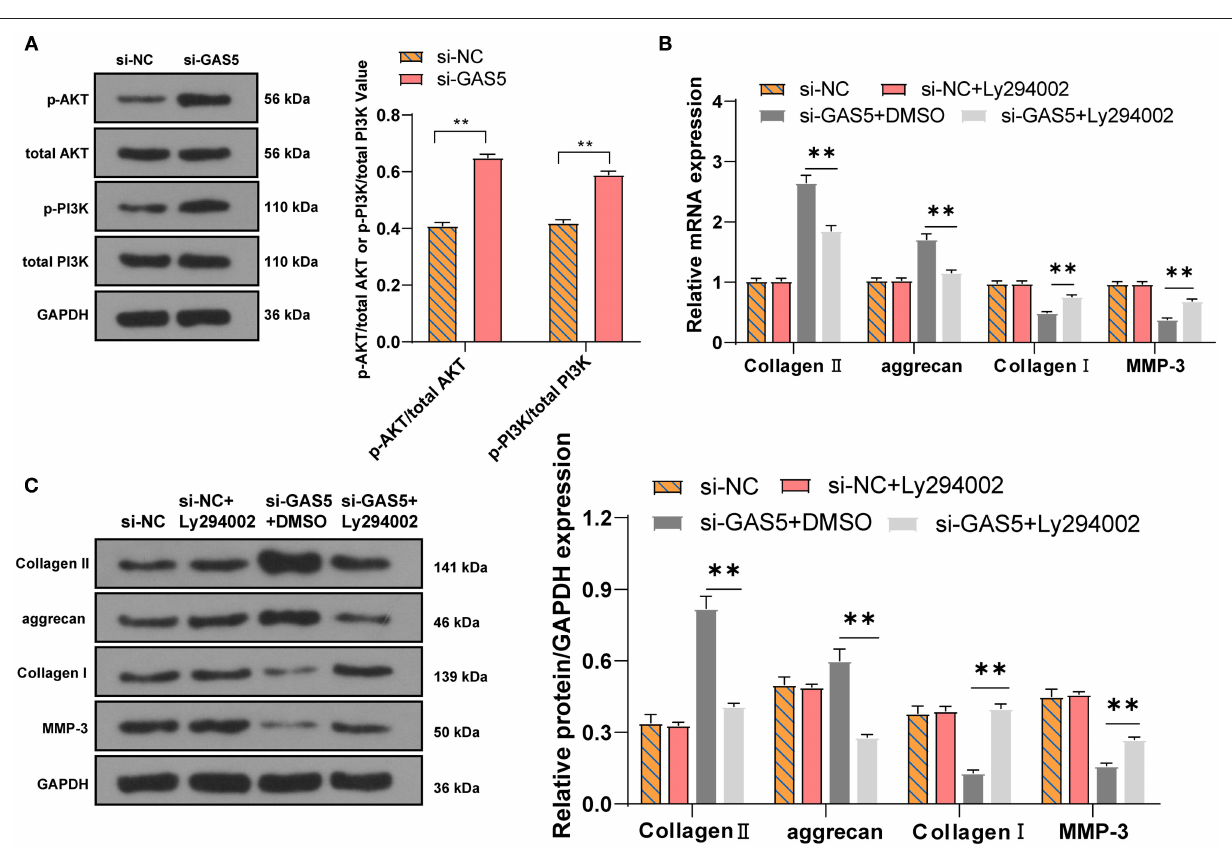
LY294002, a PI3K/Akt inhibitor, was added to the degenerative NPCs with GAS5 knockdown. The levels of Collagen II and aggrecan in the si-GAS5 + LY294002 group were